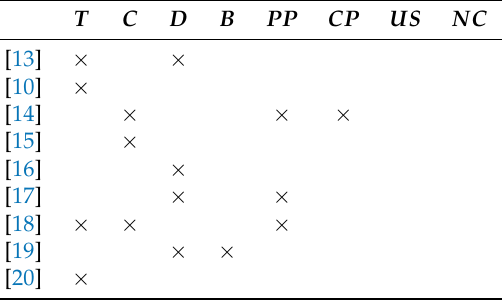
Table 2. Optimization criteria found in the